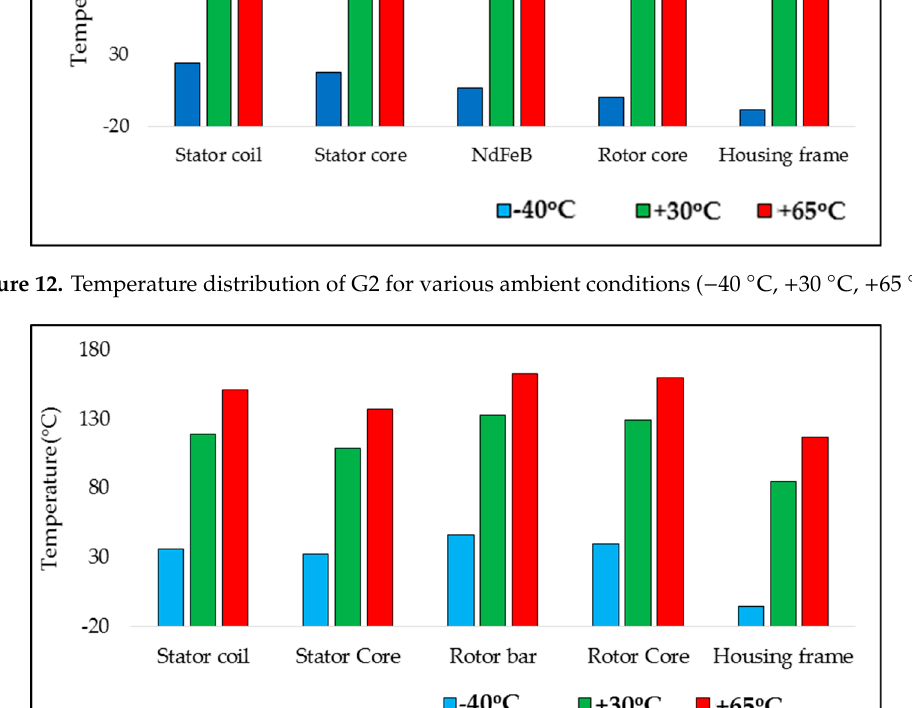
Figure 13. Temperature distribution of G3 for various ambient conditions ( − 40 ◦ C, + 30 ◦ C, + 65 ◦ C).